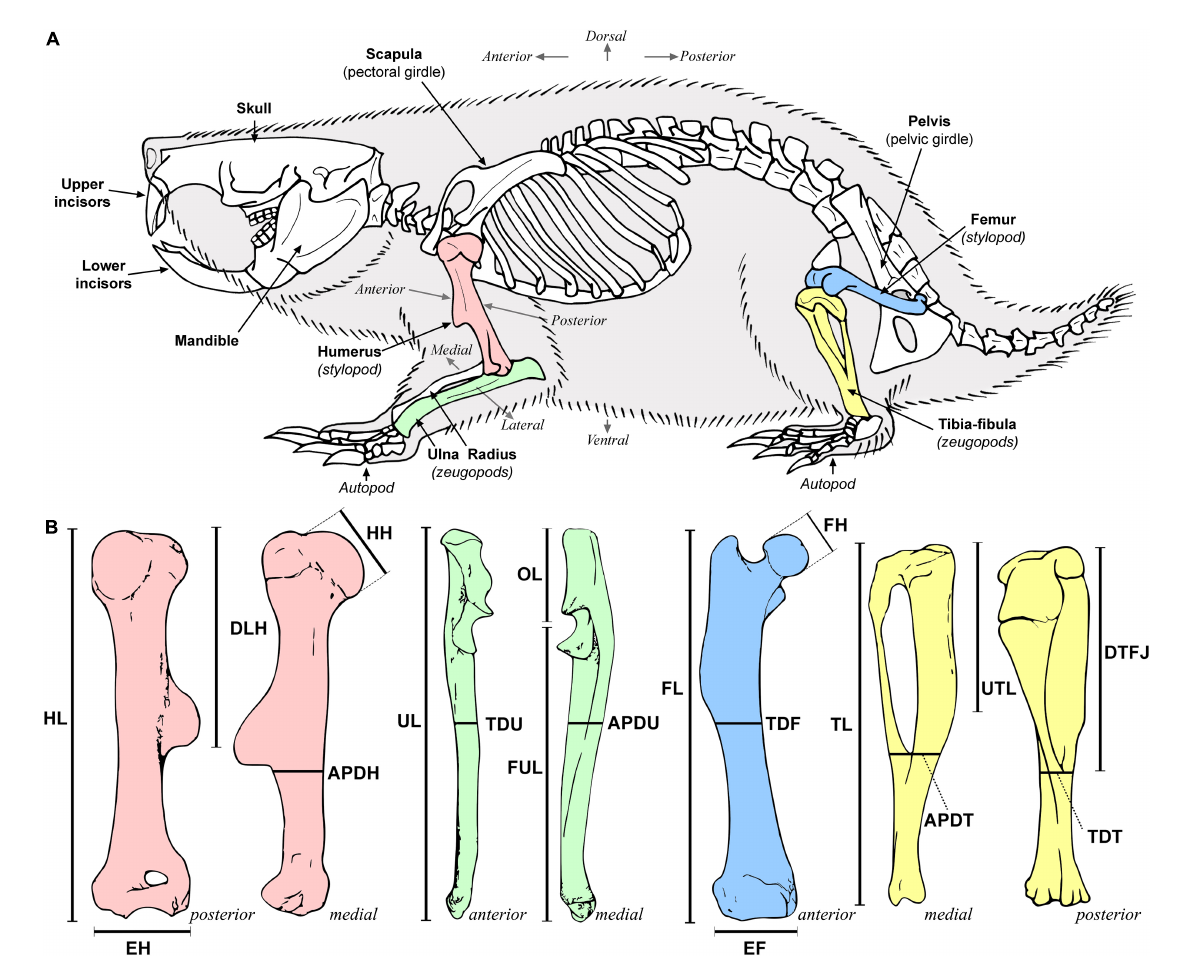
FIGURE2 Skeletal anatomy and appendicular morphology of mole-rats. (A) Anatomical and directional terminology used to describe the relative position of structures in the skeleton. Bones analyzed are in colors: humerus (red), ulna (green), femur (blue), and tibia-fibula (yellow). (B) Linear measurements obtained in this study. Total lengths of humerus (HL), ulna (UL), femur (FL), and tibia-fibula (TL); transversal diameters of ulna (TDU), femur (TDF), and tibia-fibula (TDT); anteroposterior diameters of humerus (APDH), ulna (APDU), and tibia-fibula (APDT); deltoid tuberosity length (DLH); humeral (HH) and femoral head (FH) diameters; humeral (EH) and femoral (EF) epicondylar widths; olecranon length (OL); functional length of the ulna (FUL); length of the distal tibio-fibular junction (DTFJ); tibial tuberosity (UTL). Linear measurements are fully described in Supplementary Methods . The skeletal anatomy, body silhouette and long bones are based on Bathyergus suillus (extracted and modified from Montoya-Sanhueza et al.,